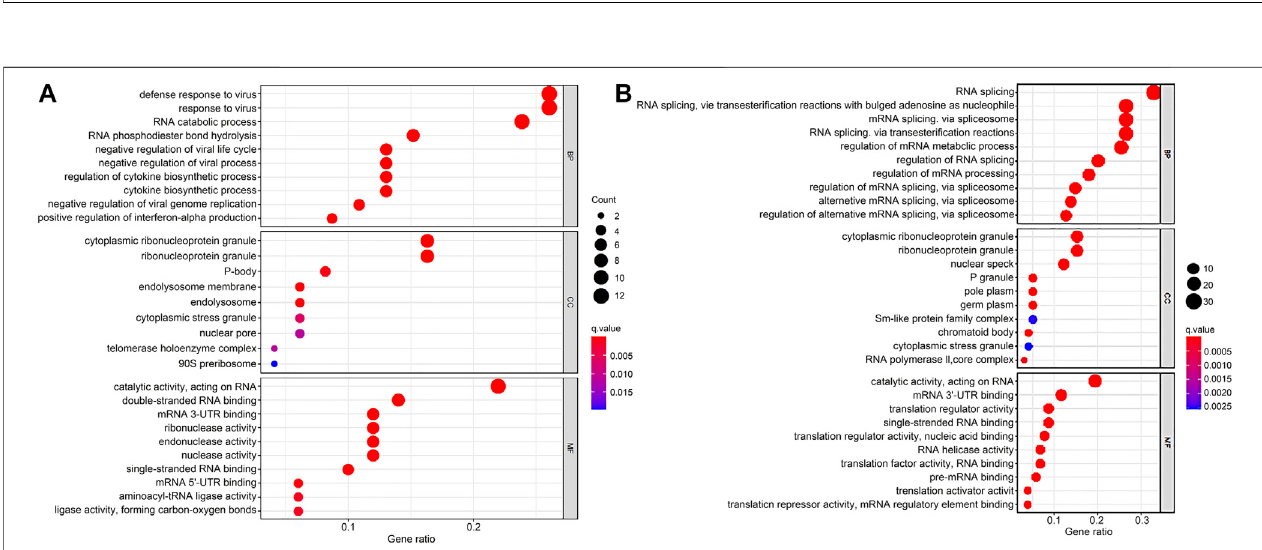
FIGURE1| TheDERBPsbetweenGBMandnormalbraintissues. (A) Volcanoplotshowingthelog 2 FCofRBPsinGBMcomparedtonormalbraintissues,andthe corresponding – log 10 FDRinTCGAandGTExdatasets.GeneswithFDRbelow0.05andlog 2 FCabove1(below-1)weremarkedwithred(blue)dots. (B) Heatmapofthe RBPs in TCGA and GTEx datasets. DERBPs, differentially expressed RBPs; FC, fold change; FDR, false discovery rate.